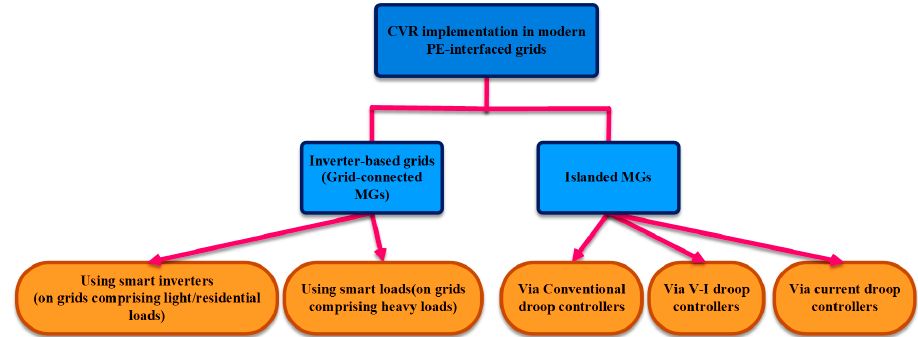
Figure 4. CVR implementation approaches in PE-based modern grids.